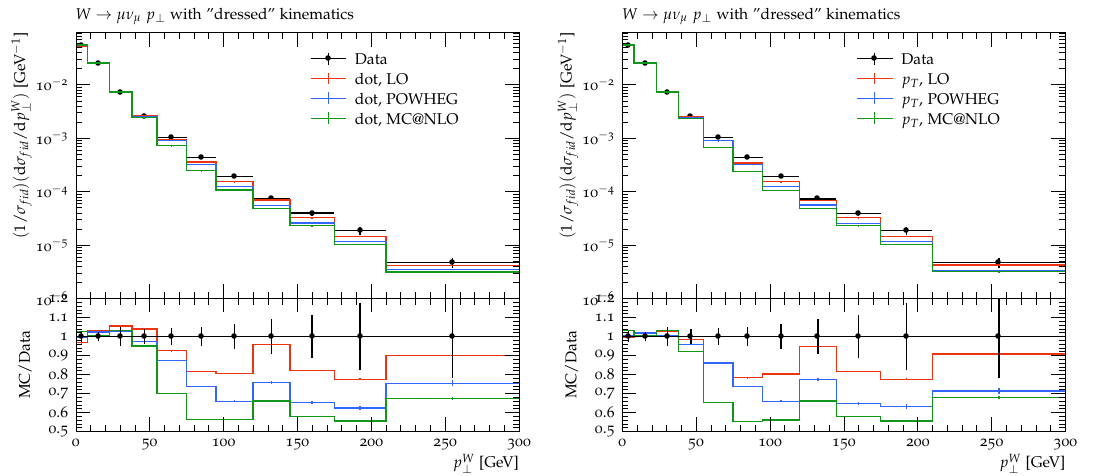
Figure 5 . Differential normalized cross section of W → µν µ as a function of W p ⊥ . Herwig compared to ATLAS [18] data at 7